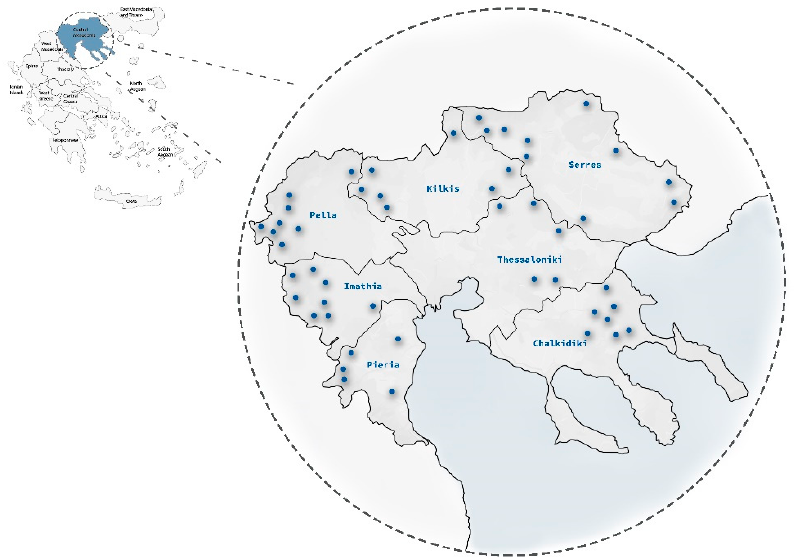
Figure 1. The study area (Region of Central Macedonia). Source: Edited Google Maps (2023).